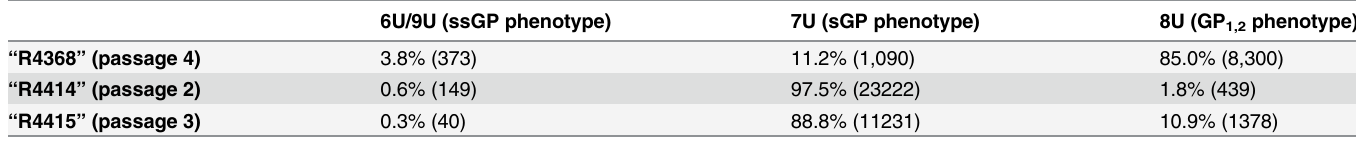
Table 4. GP gene editing site composition in EBOV/Kik-9510621 NHP challenge stocks.